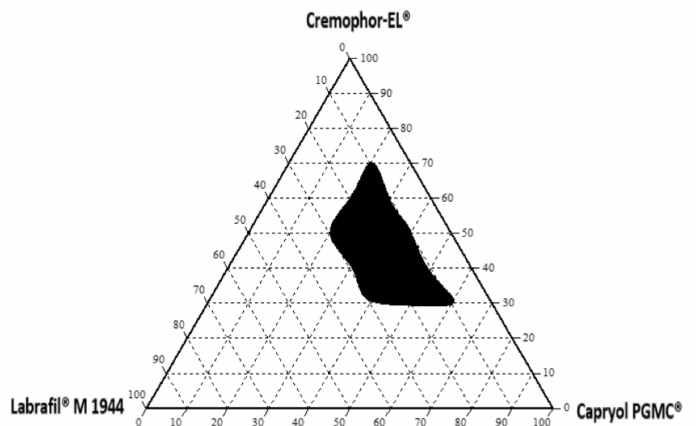
Figure 2. Phase diagram of oil (Capryol PGMC ® ), surfactant (Cremophor-EL ® ), and cosurfactant (Labrafil M ® 1944 CS).